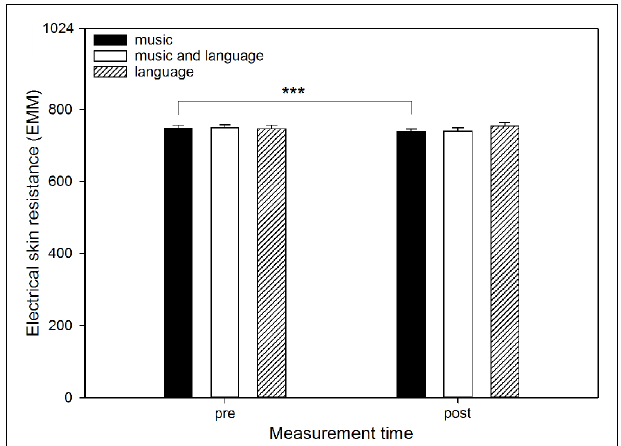
FIGURE 3 | Perceived stress by listening aim before and after using the app. The graph shows the EMM of perceived stress before (pre) and after (post) using the app, separated by the two aims (“relaxation,” “activation”). Error bars represent standard errors of EMM. There was a significant increase from before to after using the app only if “relaxation” had been selected as the aim. Sessions conducted in the mode “language” were not included in the data, because in this mode there was no option of selecting an aim. ∗∗ p <